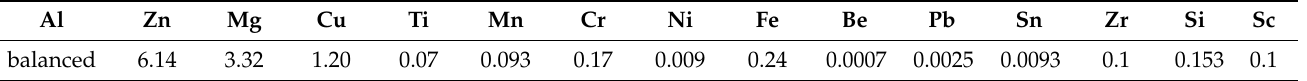
Table 1. Chemical composition of Al-Zn-Mg-Cu-0.1%Zr-0.1%Sc